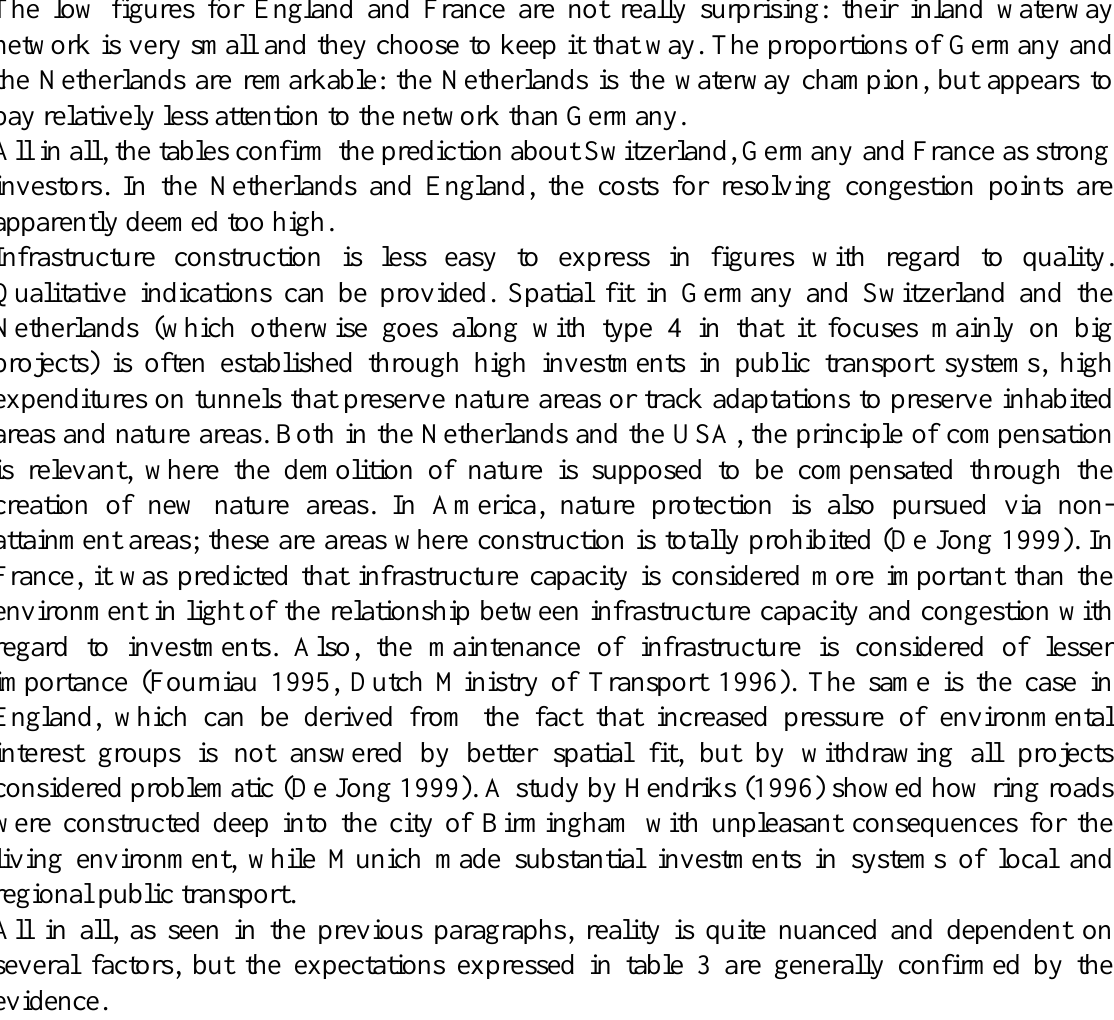
Table 12. Expenditure for waterways (1995) Country Investments per capita Investments in waterways/length of (in fl 1.00/inhabitant) waterway network (in fl. 1000/km) Germany 37 290 Netherlands 44 140 England 0 0 France 6